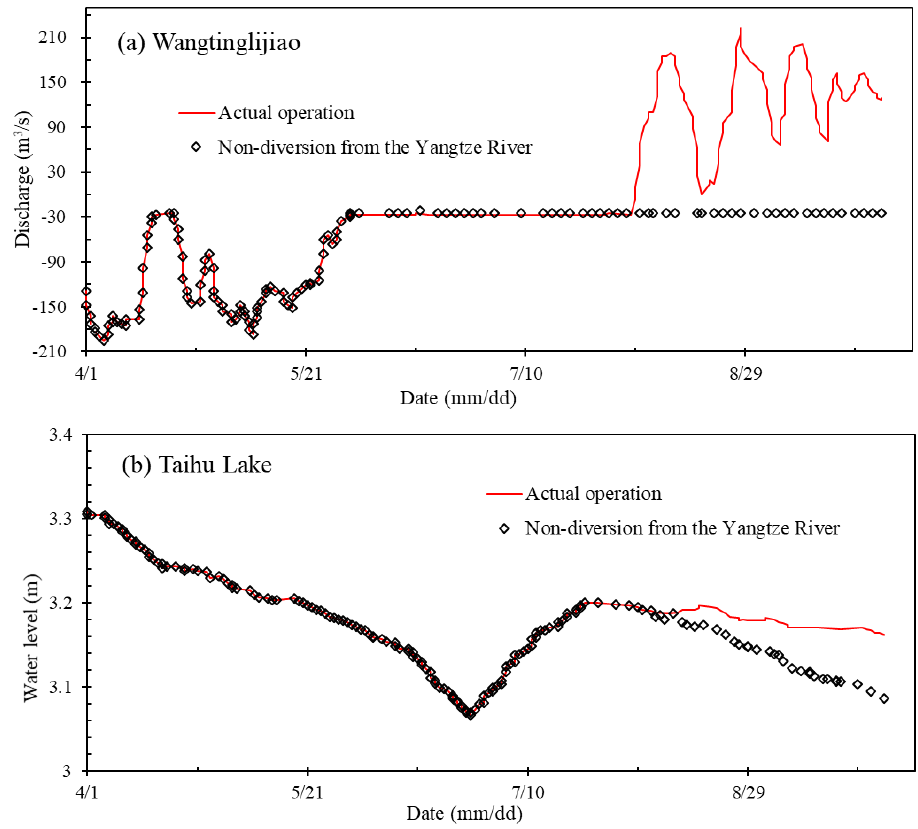
Figure 13. ( a ) The discharge at Wangtinglijiao and ( b ) the water surface elevation in Taihu Lake under conditions of diversion and non-diversion from the Yangtze River.